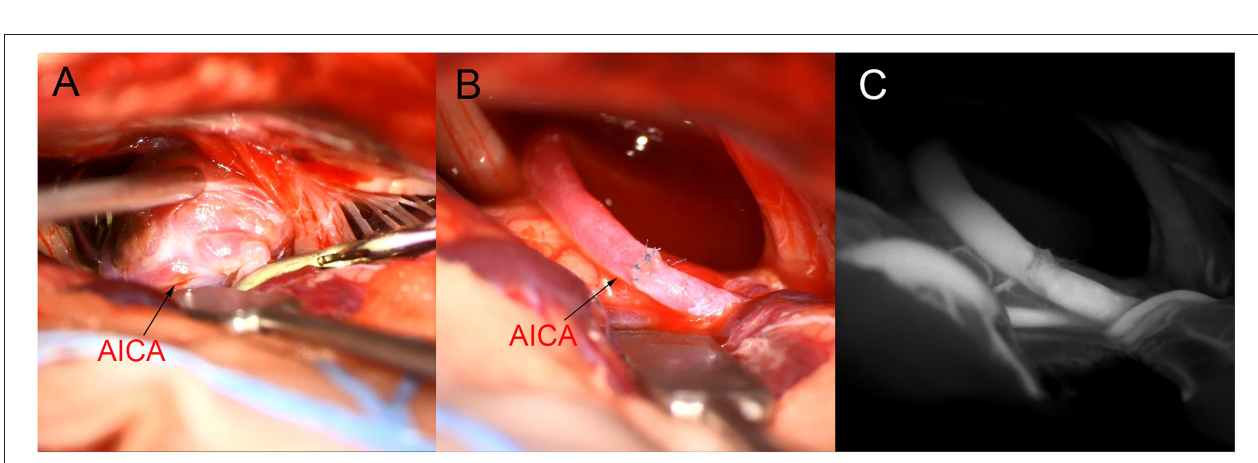
FIGURE 3 | Intraoperative image. (A) : Aneurysm neck and parent artery were not clearly defined. (B,C) : a2AICA-a2AICA anastomosis in situ after aneurysm resection, intraoperative fluorescence imaging confirmed